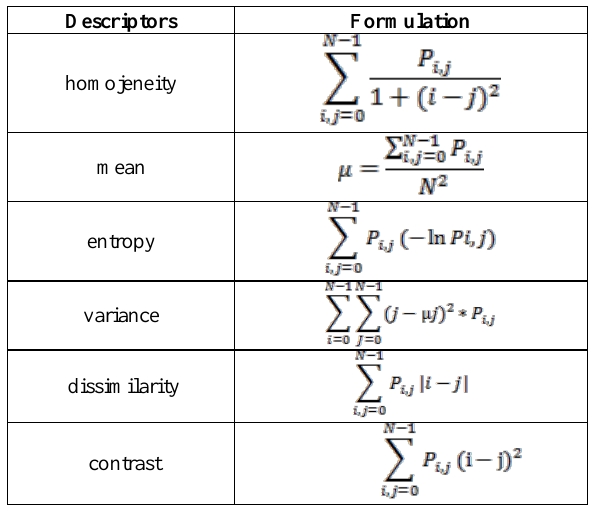
Table 1. Extracted descriptors using the Co-occurrence matrix